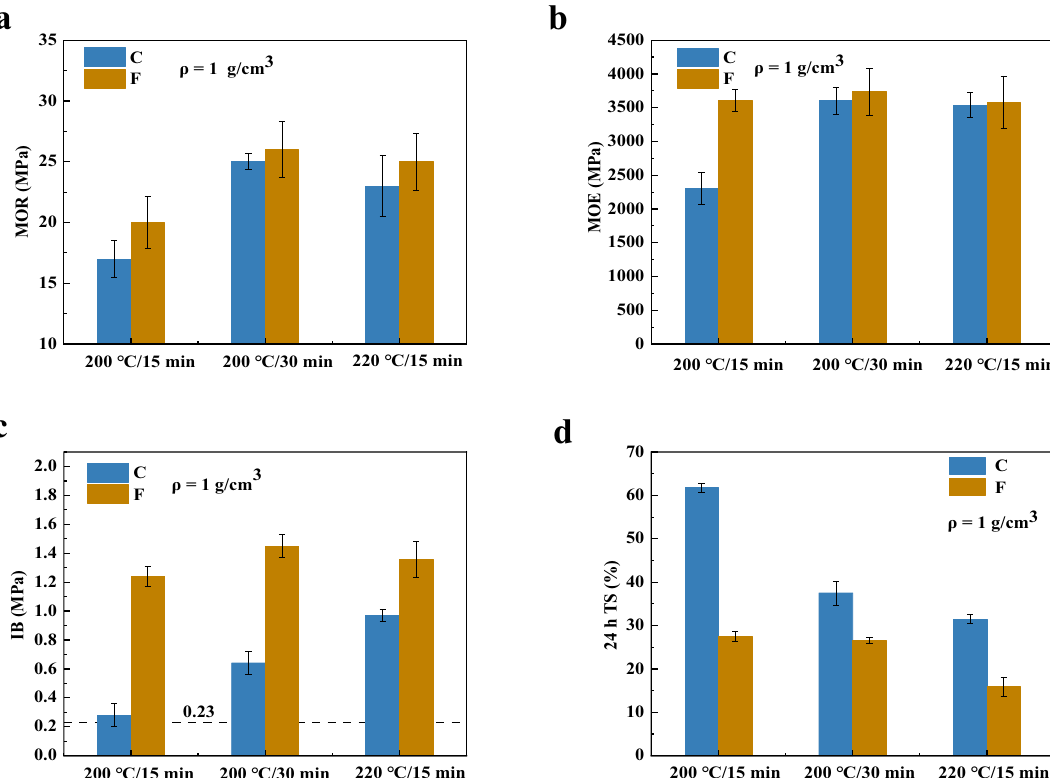
Fig. 4 Effects of particle size on physical and mechanical properties of binderless boards. a Effects of particle size on the MOR of binderless board. b Effects of particle size on the MOE of binderless board. c Effects of particle size on the IB of binderless board. d Effects of particle size on 24 h TS of binderless board. Error bars indicate standard